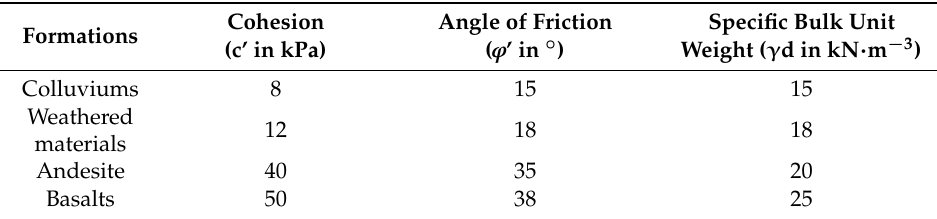
Table 3. Geotechnical values retained for modeling